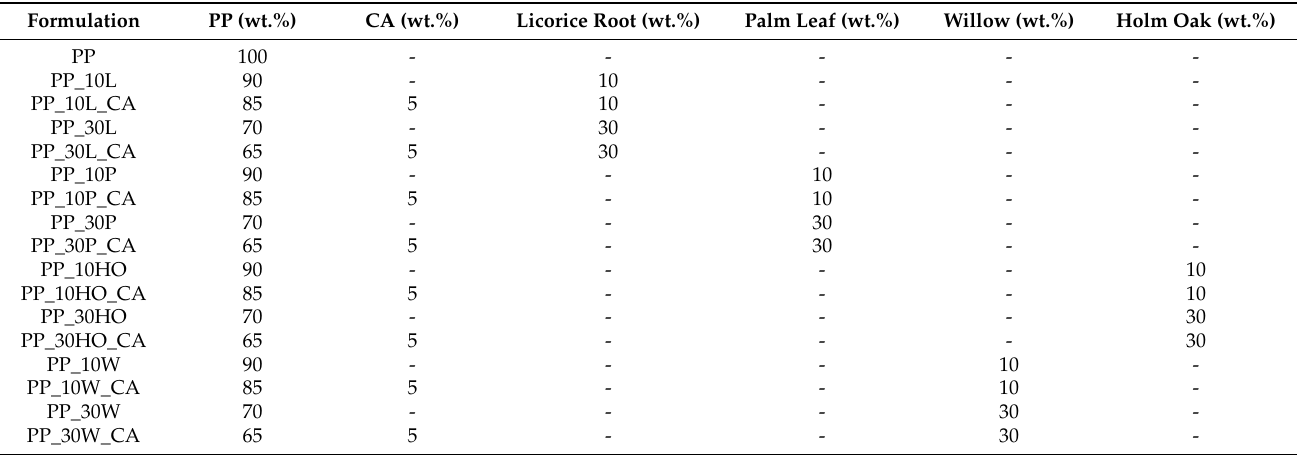
Table 2. List of PP-based